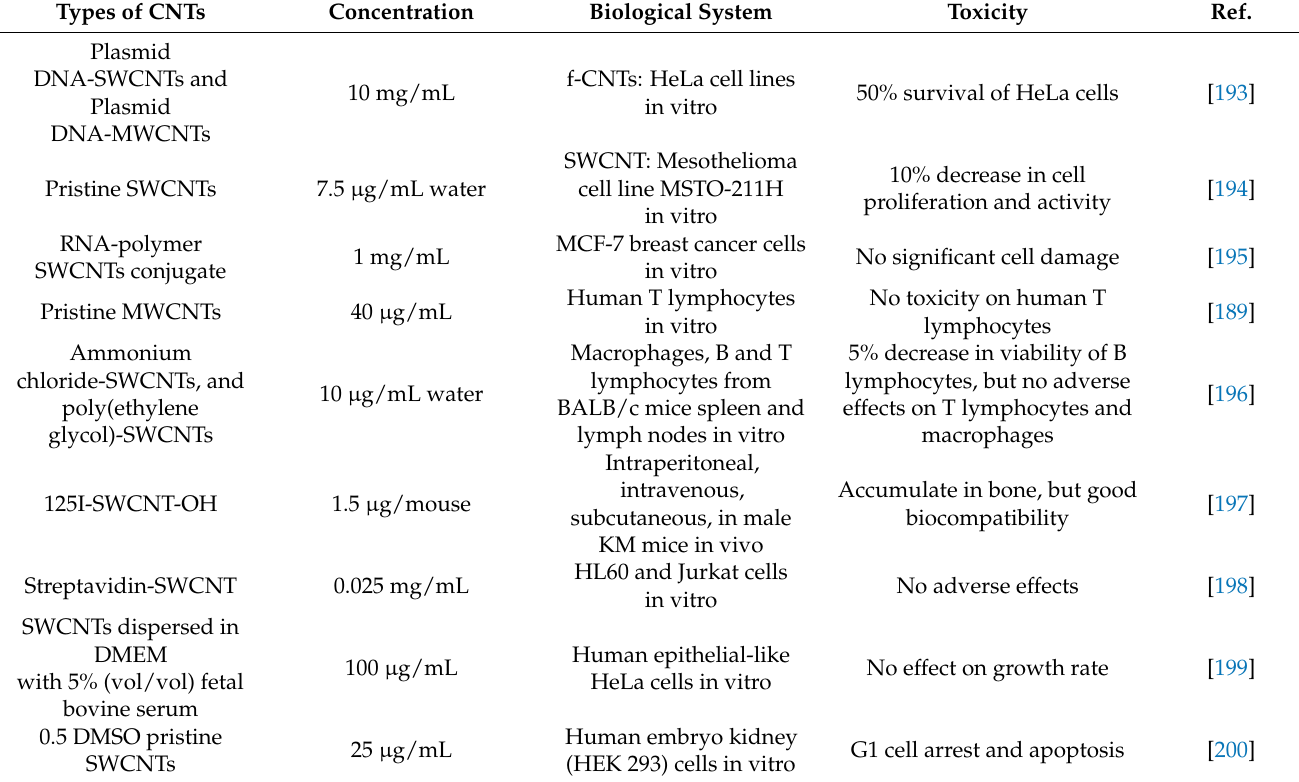
Table 5. Compilation literature studies of toxicity cellular and tissue of different concentration and types of CNT. Types of CNTs Concentration Biological System Toxicity